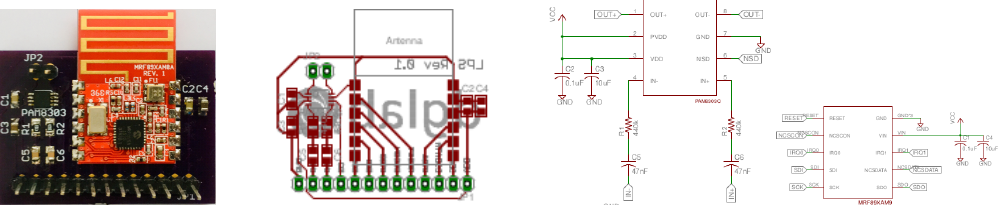
Figure 3. Miniature speaker KDMG10008C encapsulated with jack connectors and its frequency response.